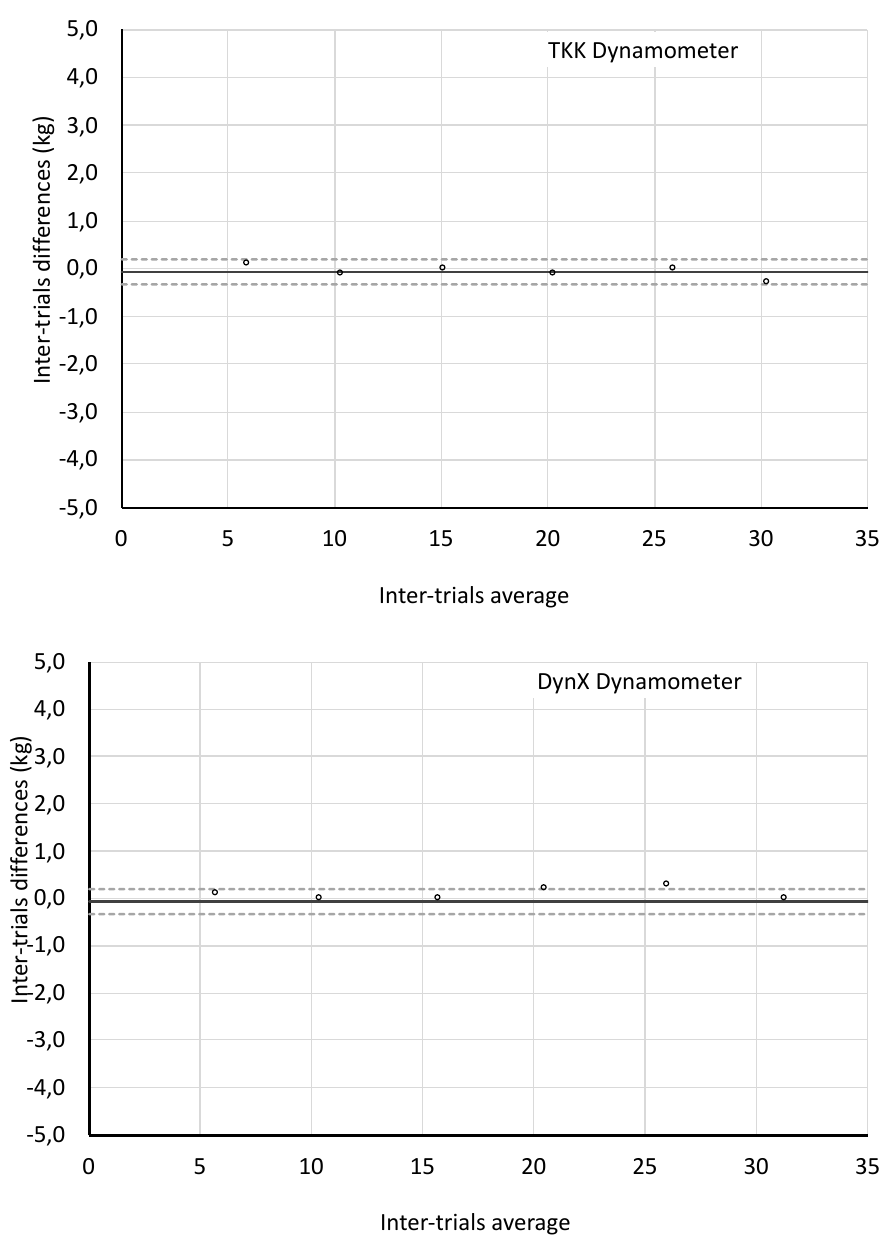
Figure 4. Reliability of weight trials of TKK and DynX dynamometers by Bland and Altman plots [32]. The central line shows the mean difference (bias) between the dynamometer weight score and the known weight. The upper and lower lines represent 95% limits of agreement (mean difference ± 1.96 SD